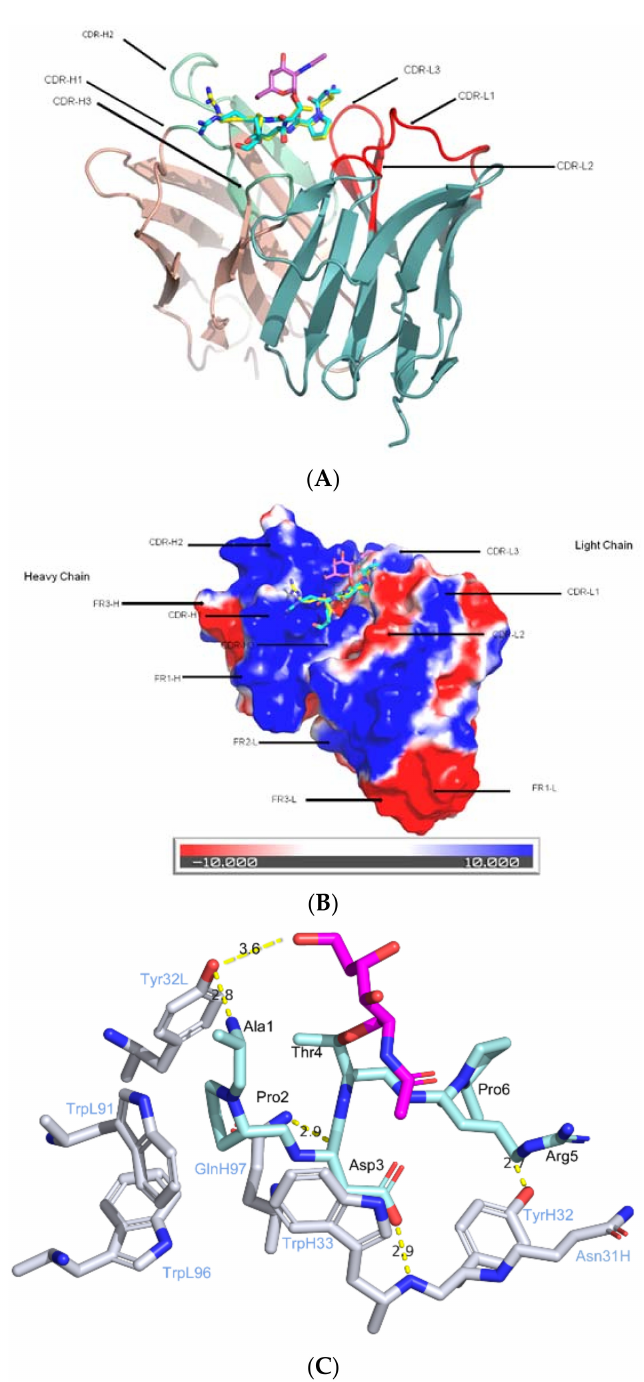
Figure 3. SM3 in complexed with MUC1 peptide and glycopeptide. ( A ) SM3 in complexed with MUC1 glycopeptide (SAPDTnRPAP) (PDB ID: 5a2i) (with carbon atoms in cyan and the sugar moiety highlighted in hot pink). The color codes for VL chains and CDR loops L1-3, as well as VH chains and CDR loops H1-3 are the same as in Figure 2; ( B ) Surface representation of SM3 with bound peptide and glycopeptide in the binding pocket. From the surface representation, the sugar moiety does not form extensive interactions with SM3, instead, similar to AR20.5 complexed structures, pointing towards the solvent; ( C ) Key residues involving in SM3 mAb-glycopeptide interactions. The color and label schemes are similar to Figure